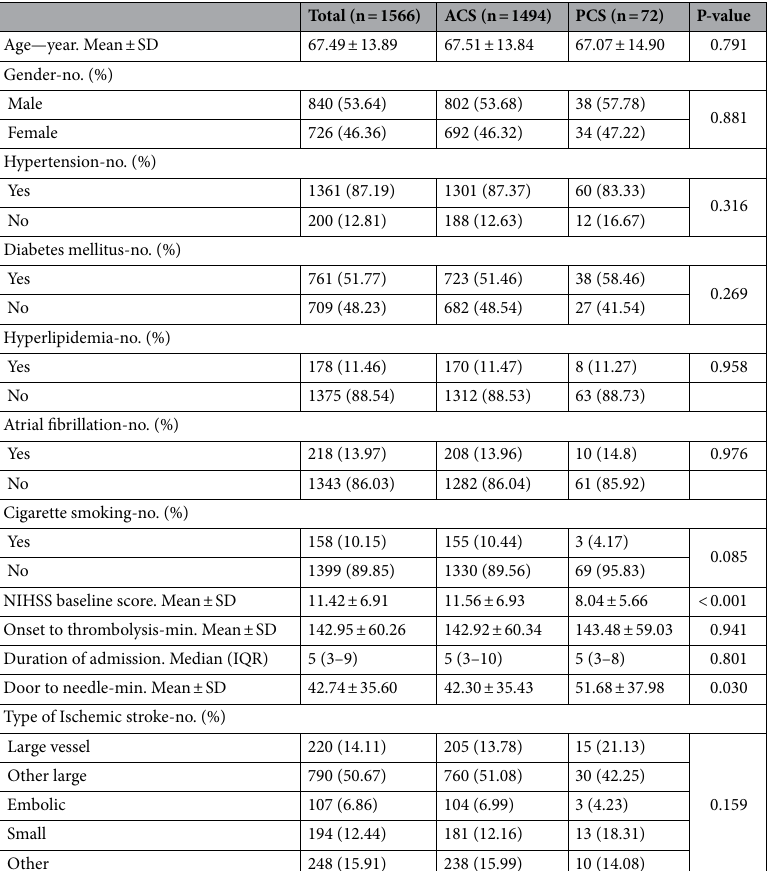
Table 1. Baseline characteristics of study population according to circulation territory. The frequency difference between total number and some of the covariates was related to missing